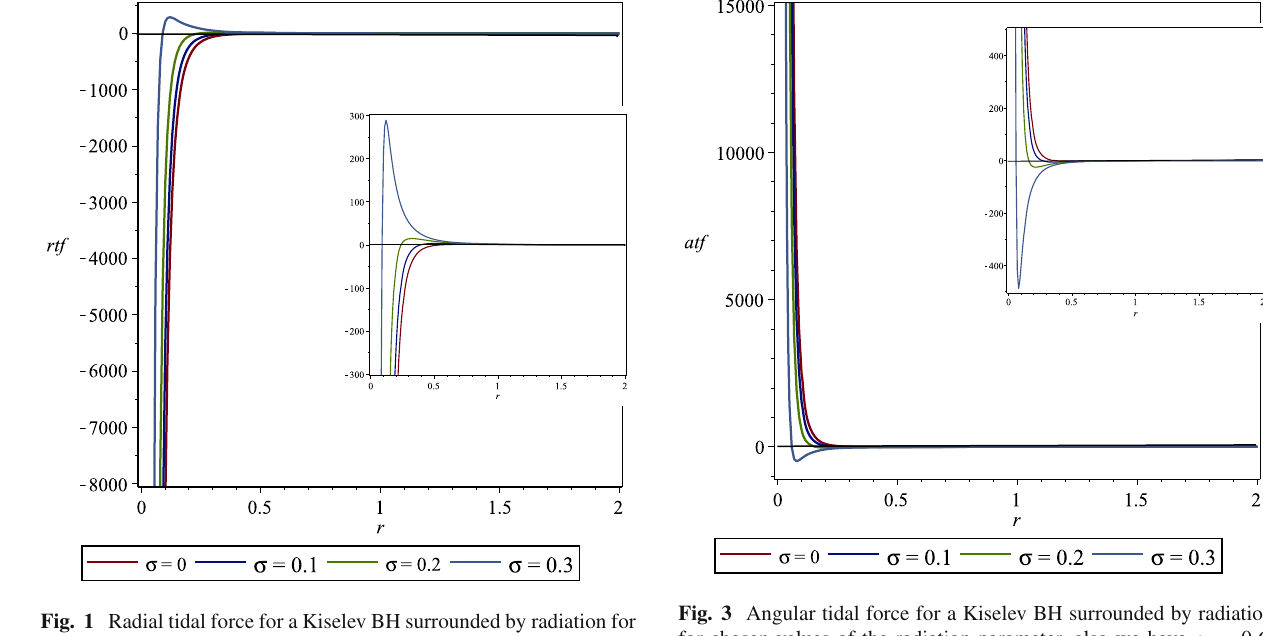
Fig. 1 Radial tidal force for a Kiselev BH surrounded by radiation for chosen values of the radiation parameter, also we have q = 0 . 6 and b = 100